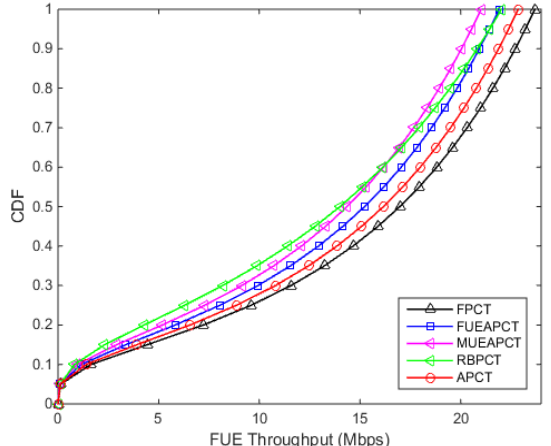
Figure 4. Downlink Throughput CDF of the Femtocell